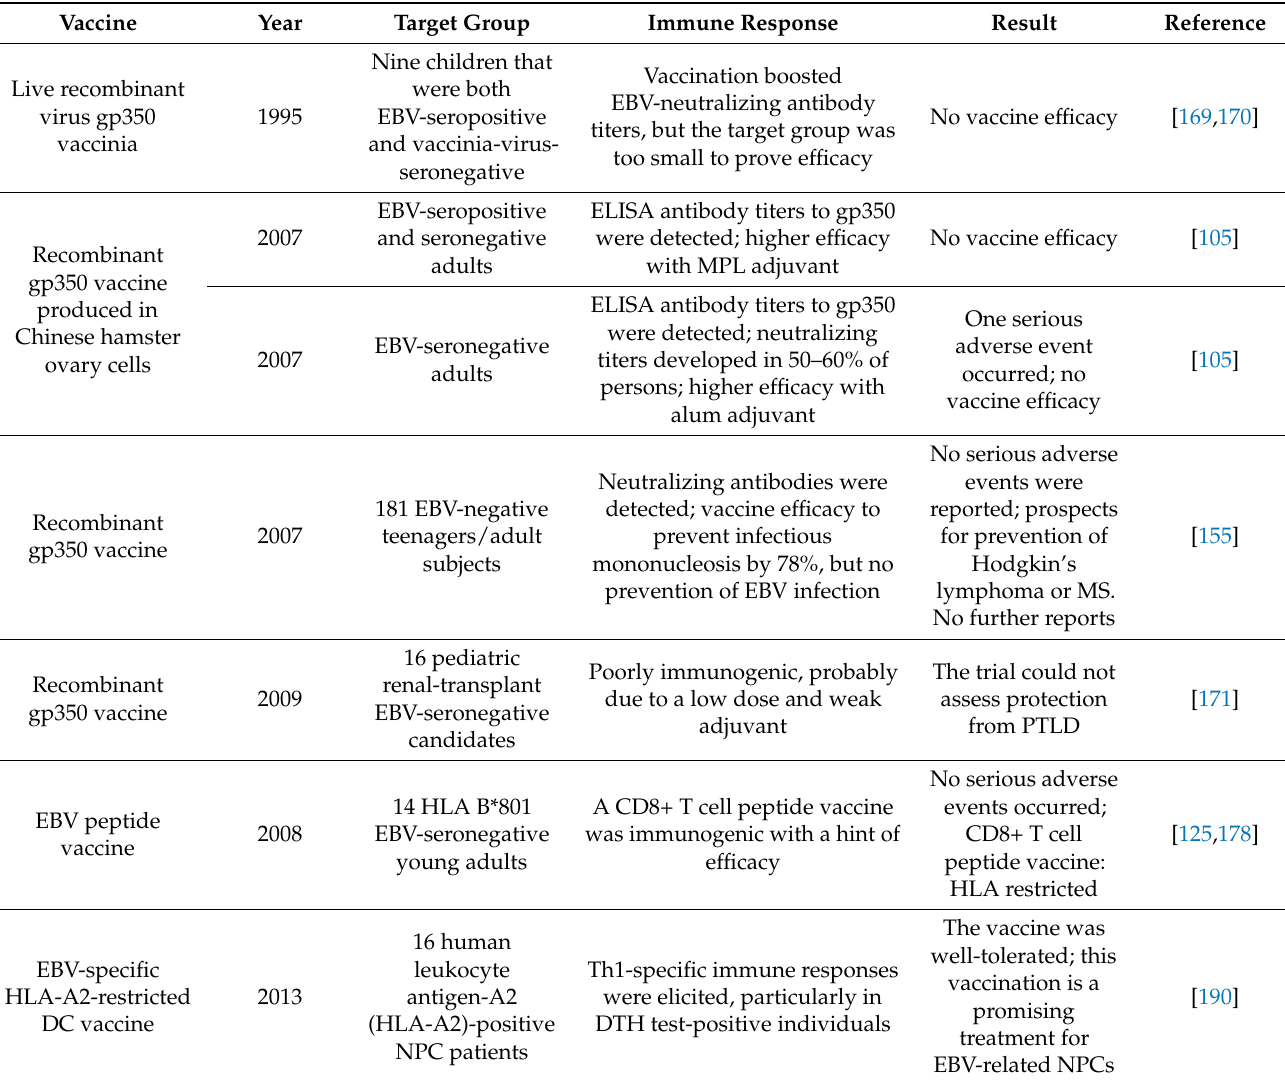
Table 1. Illustration of completed and documented EBV vaccine